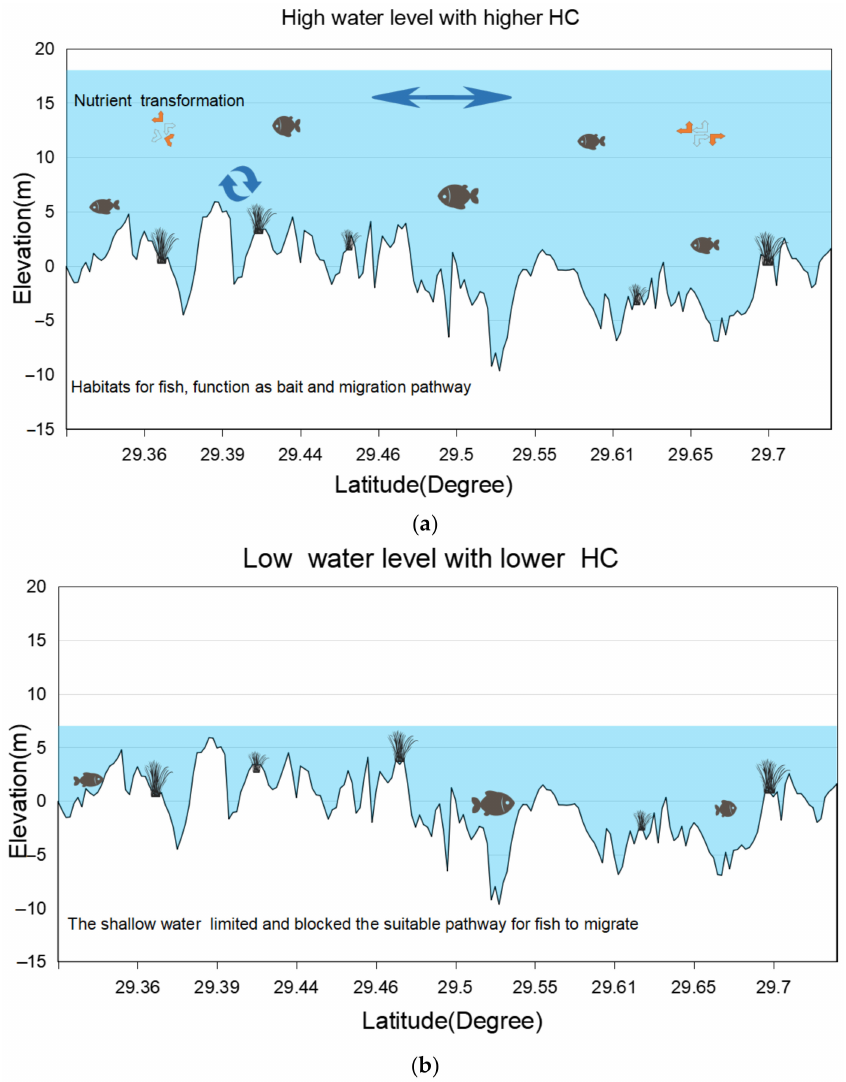
Figure 11. The significance of HC and ecological function for migratory fish under ( a ) high water level conditions and ( b ) low water level conditions are illustrated for the study